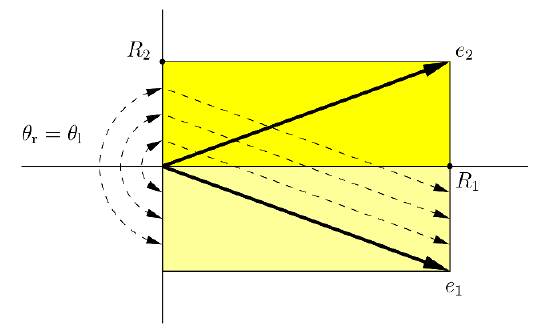
Figure 1 . Two-dimensional M(cid:127)obius strip as Z 2 orbifold: the underlying two-torus lattice is spanned by e 1 and e 2 . The upper and lower yellow regions combined give a convenient choice for the funda- mental domain of the resulting two-torus. The symmetric twist (cid:18) r = (cid:18) l gives a re(cid:13)ection at the hori- zontal axis. Consequently, we may take the lower yellow region to represent a fundamental domain of the resulting Z 2 orbifold. In this picture the 3+3 dashed arrows illustrate how the left and right side of the lower yellow region get glued together, hence this orbifold corresponds to the M(cid:127)obius